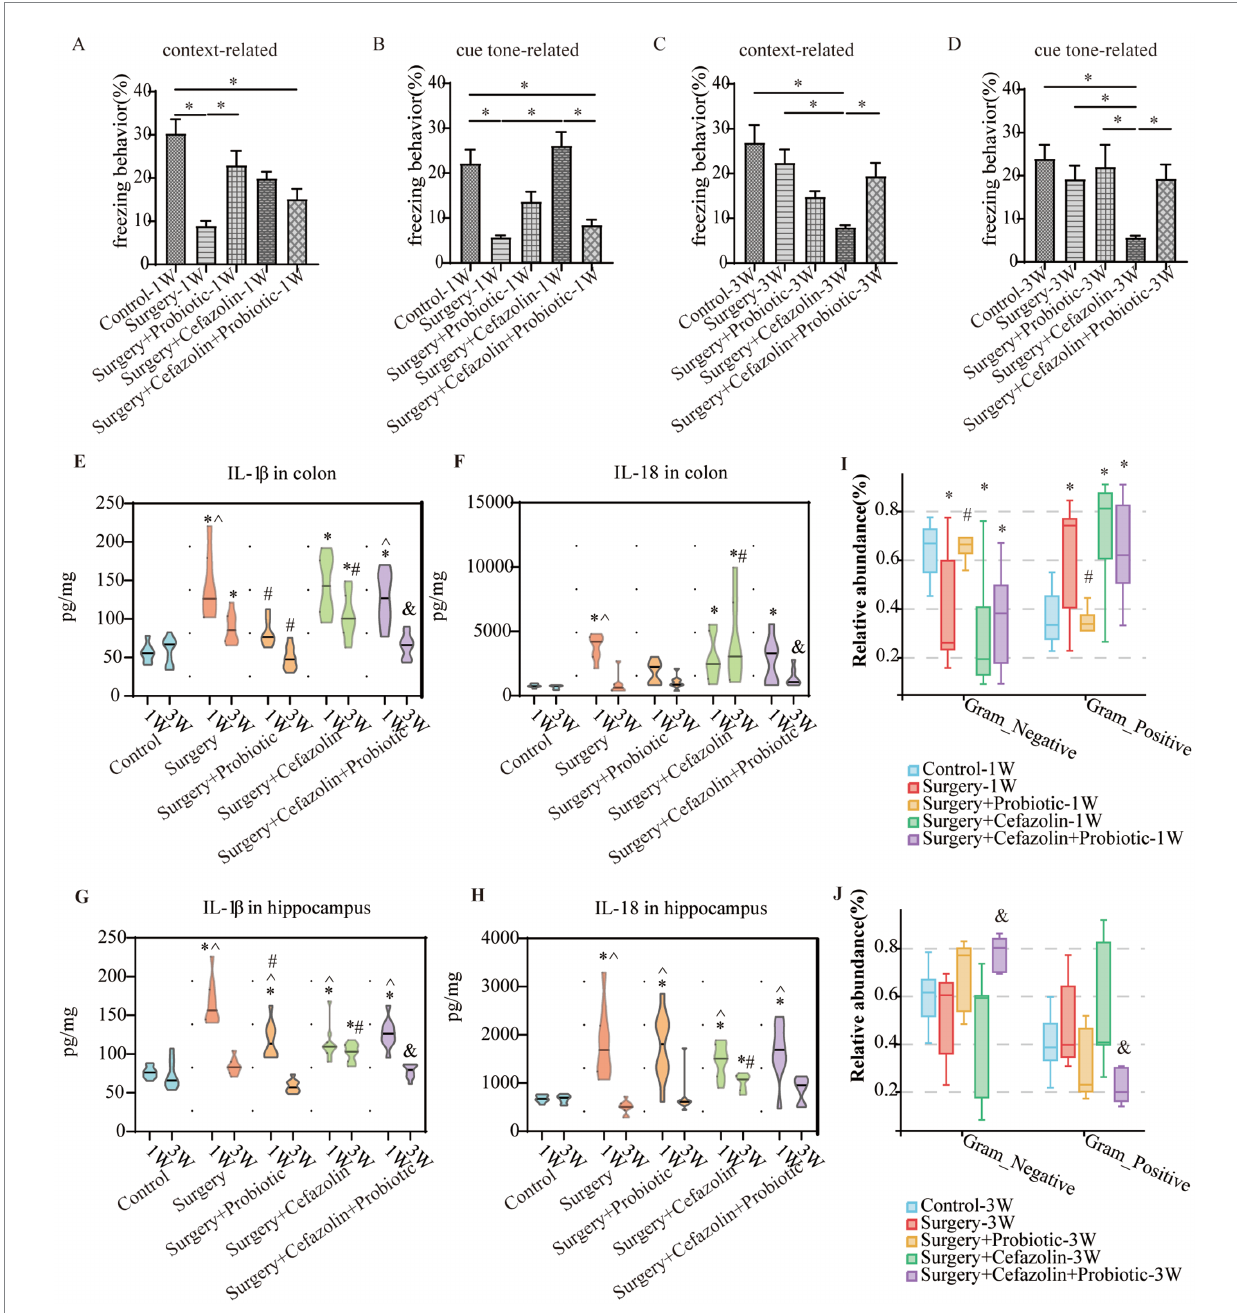
FIGURE 6 The probiotics administration for surgery/anesthesia stress-induced and perioperative cefazolin-induced gut dysbacteria, and cognitive dysfunction, respectively. (A,B) Probiotics improved context-related (q = 5.58, p = 0.0024) but not cue tone-related (q = 3.597, p = 0.099) freezing behavior decreased by surgery/anesthesia stress at 1 week ( n = 10, ANOVA with Tukey’s multiple comparisons test). (C,D) Surgery + cefazolin group showed a decreasing context-related (q = 6.984, p = 0.0001) and cue tone-related (q = 5.406, p = 0.0035) freezing behavior compared with the control group at 3 weeks; probiotics could improve these context-related (q = 4.224, p = 0.035) and cue tone-related (q = 4.024, p = 0.0495) freezing behavior ( n = 10, ANOVA with Tukey’s multiple comparisons test). (E,F) ELISA: probiotics inhibited the increasing IL-1 β (q = 5.183, p = 0.0078) in the colon at 1 week caused by surgery; probiotics inhibited the increasing IL-1 β (q = 6.238, p = 0.0006) and IL-18 (q = 4.601, p = 0.0219) in the colon at 3 weeks after surgery compared with surgery + cefazolin group ( n = 10, ANOVA with Tukey’s multiple comparisons test). (G,H) ELISA: probiotics inhibited the increasing IL-1 β (q = 5.183, p = 0.0078) in the hippocampus at 1 week caused by surgery; probiotics inhibited the increasing IL-1 β (q = 6.653, p = 0.0002) in the hippocampus at 3 weeks after surgery compared with surgery + cefazolin group ( n = 10, ANOVA with Tukey’s multiple comparisons test). (I,J) Probiotics could reverse the increasing relative abundance of gram-positive bacteria (q = 0.0083, p = 0.0028) and decreasing gram-negative bacteria (q = 0.0083, p = 0.0028) caused by surgery at 1 week, but not surgery + cefazolin; probiotics could reverse the increasing relative abundance of gram-positive bacteria (q = 0.0055, p = 0.0018) and decreasing gram-negative bacteria (q = 0.0055, p = 0.0018) caused by surgery + cefazolin at 3 weeks ( n = 9, KW rank sum test with Wilcoxon rank sum test). Grp, group; CTL, control; S, surgery; SC, surgery combined with cefazolin; SP, surgery combined with probiotics; SCP, surgery combined with cefazolin and probiotics; G + , gram-positive bacteria; G − , gram-negative bacteria. *Compared with Grp CTL, p < 0.05; # compared with Grp S, p < 0.05; & compared with Grp SC, p < 0.05; ^ compared with 3 weeks, p <